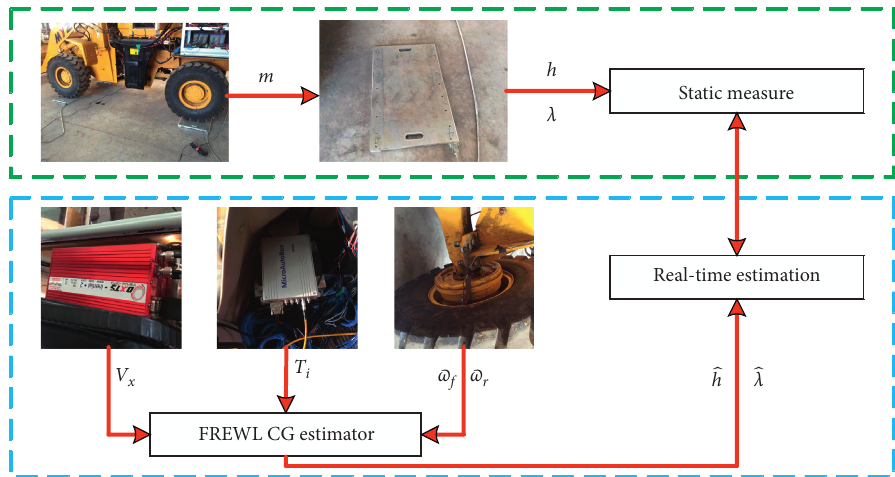
Figure 6: Two measurement methods used in the experiment.